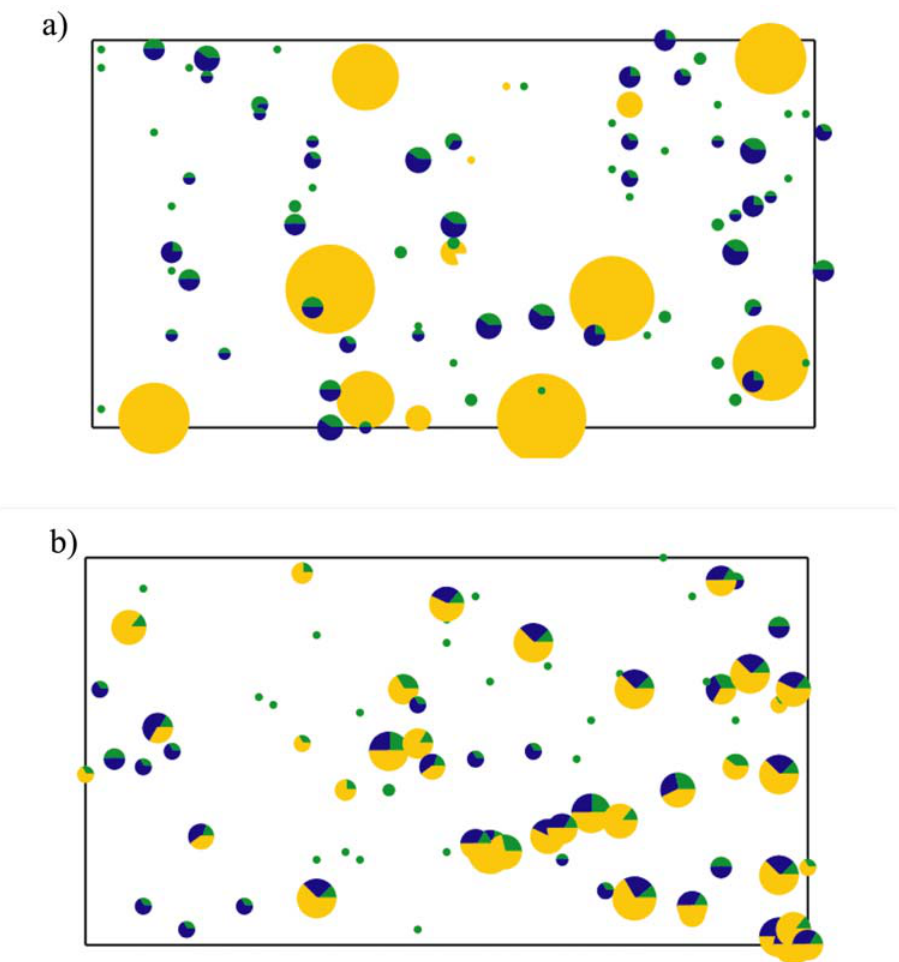
Figure 1. Examples of the initial conditions of the networked city. The size of the dots reflect the number of people within a household or a home for the elderly. The color of the dots reflects the age group involved: blue for youth 0–18 yrs, green for adults 19–55 yrs, and yellow represents the mature population 55 + years. (a) An example of a city containing nuclear families where the aged population is housed in large group facilities. (b) A similar example of a city containing extended families where the aged population stays with the family.